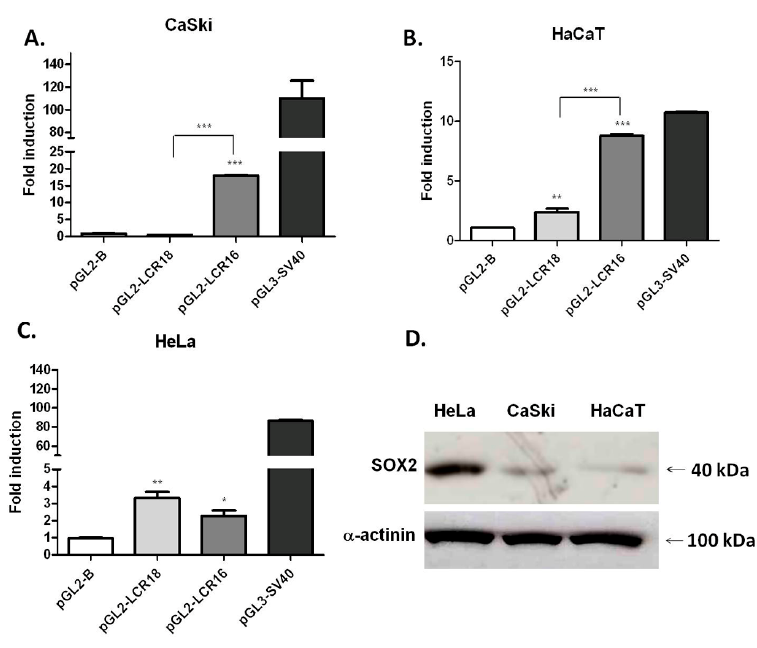
Figure 2. HPV16- and HPV18-LCRs present a different transcriptional activity in cells with distinct histological origin. Reporter plasmids were transfected in CaSki ( A ), HaCaT ( B ) and HeLa ( C ) cell lines. The transcriptional activity is shown as the fold induction, compared to the pGL2-B vector. The standard error of the mean is shown; * p < 0.05, ** p < 0.01, *** p < 0.001. The square brackets show differences between transcriptional activities of LCRs from HPV16 and HPV18. pGL3-simian virus 40 (SV40) plasmid harboring SV40 promoter was used as a positive control. The graphs show representative experiments carried out in triplicate and repeated three times; ( D ) Representative western blot of SOX2 basal protein levels in HeLa, CaSki and HaCaT cell lines. For loading control α - actinin was used.